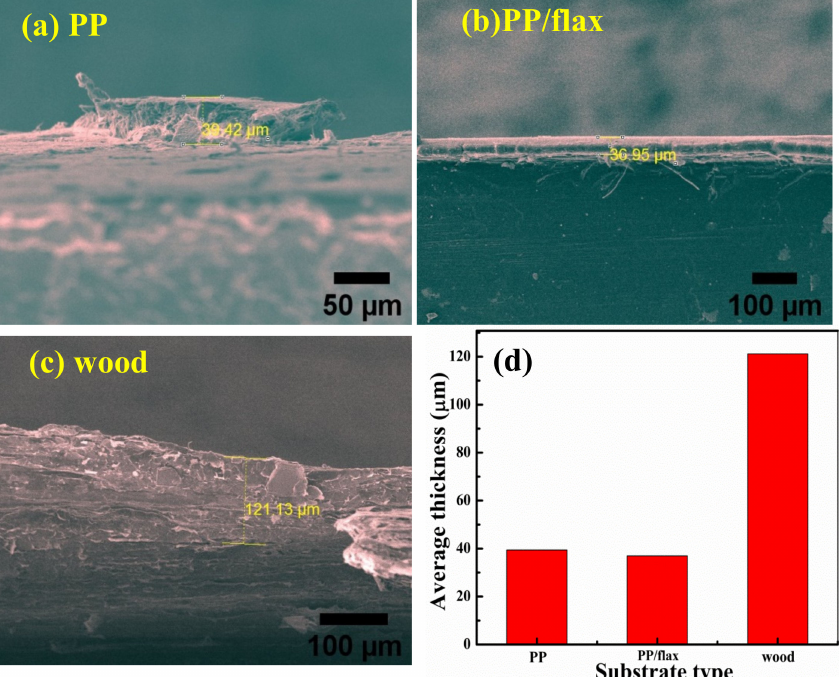
Figure 3. Cross section profiles of the coating through FE-SEM ( a ) PP ( b ) PP/flax ( c ) wood and ( d ) average thickness